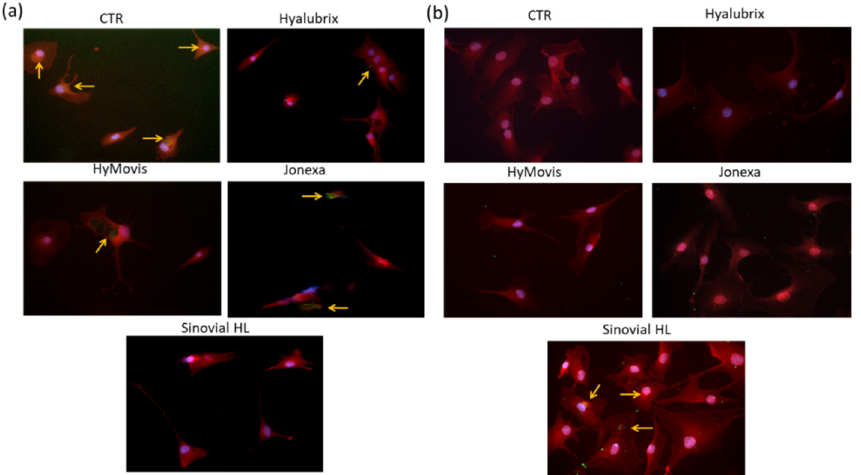
Figure 7. Immunofluorescence staining of COMP-2 ( a ) in treated and untreated primary human chondrocytes; HAS-1 ( b ) in treated and untreated primary human synoviocytes. In blue nuclei, actin fibers of cytoskeleton were stained with tritc phalloidin, and fitc-green antibodies were used for COMP-2 and HAS-1, respectively. Arrows indicate COMP-2 and HAS-1 expression in treated and untreated human primary cells. Pictures were from one representative experiment. Magnification = 40×.